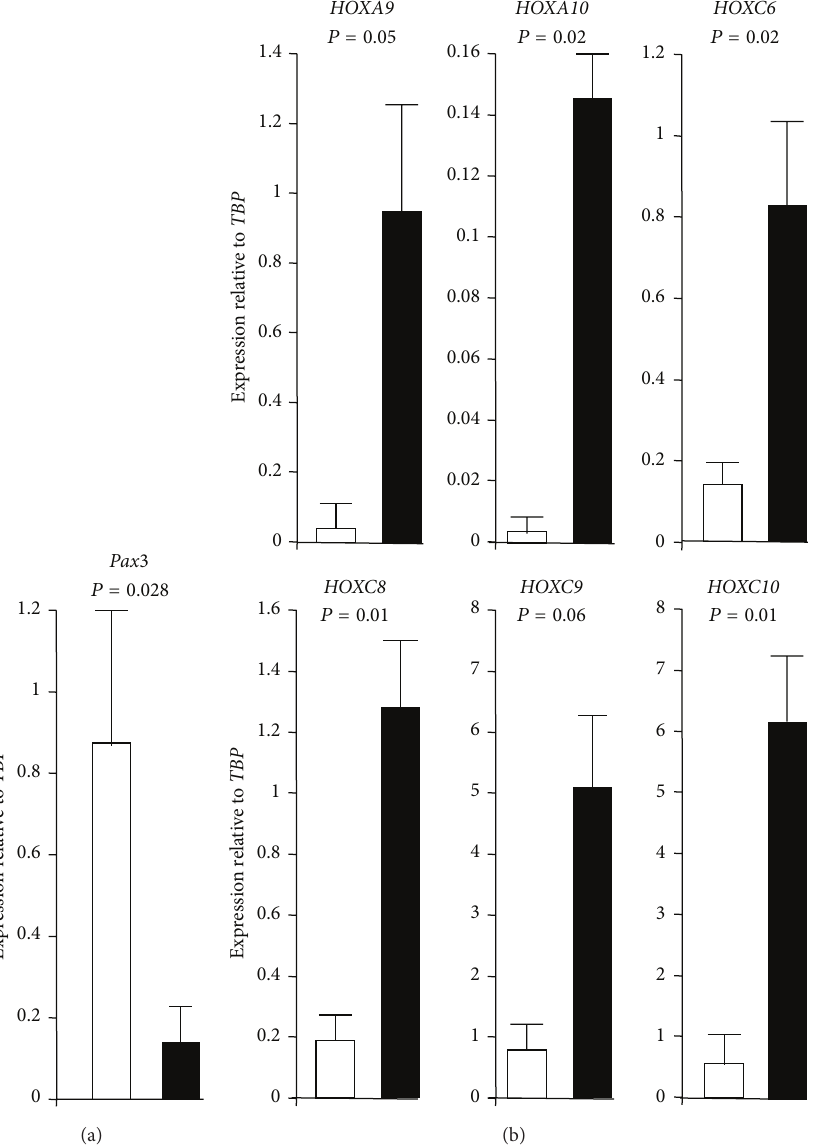
Figure 2: Expression of Pax3 and HOX genes in adipose-stromal cells derived from chin and knee fat: ASCs were isolated from chin (open bars) and knee (black bars) paired fats and were expanded ex vivo . (a) Pax3 expression was quantified by real-time PCR and normalized with TBP housekeeping gene. Values are means ± SEM. 𝑃 is indicated ( 𝑛 = 4 paired depots). (b) Expression of indicated HOX genes was quantified by real-time PCR and normalized with TBP housekeeping gene. Values are means ± SEM. 𝑃 are indicated ( 𝑛 = 3 paired